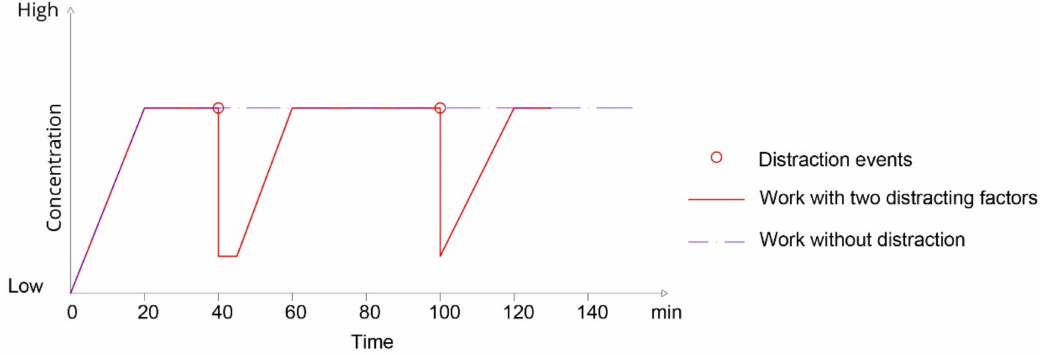
Figure 2. Time incidence of the distraction factors on worker’s concentration. Figure re-edited from [19].